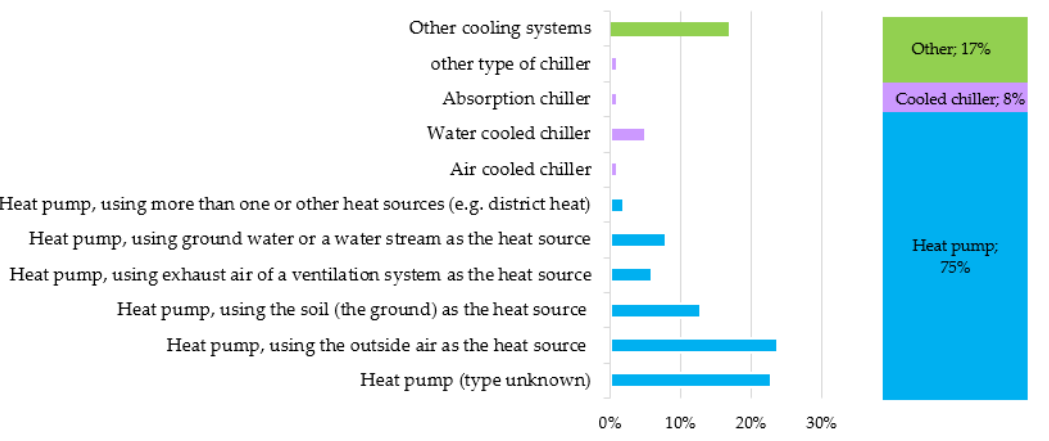
Figure 21. Share of cooling system typologies used in selected nZEBs (a total of 101 buildings with cooling systems).